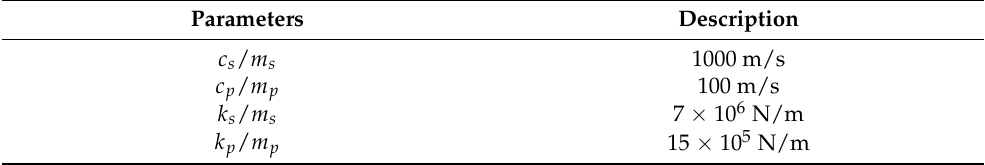
Table 1. Value of parameters in the dynamic